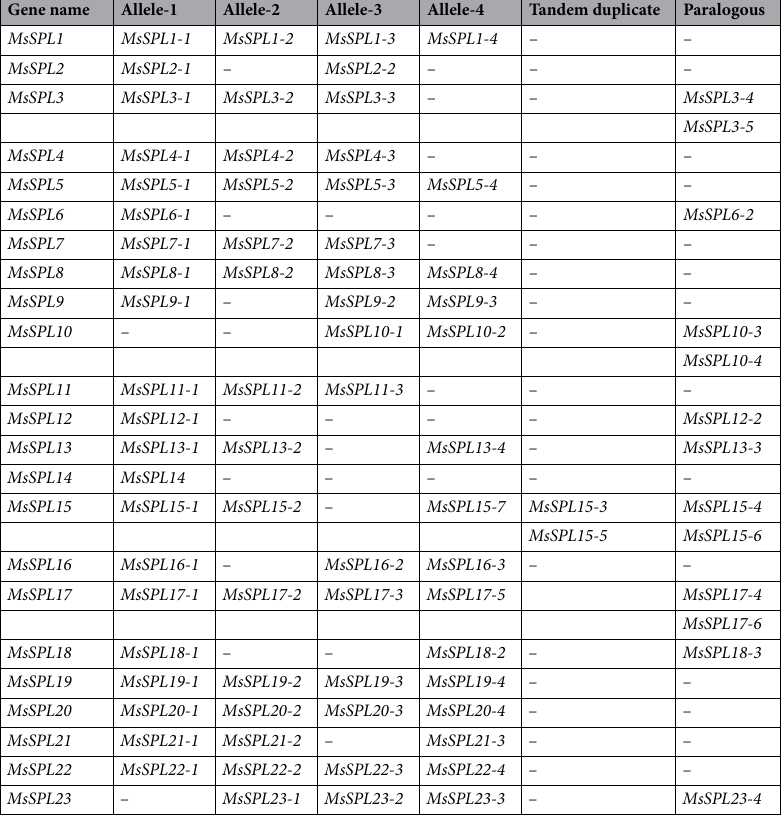
Table 1. Identification of the alleles and duplicates of MsSPL genes in alfalfa.